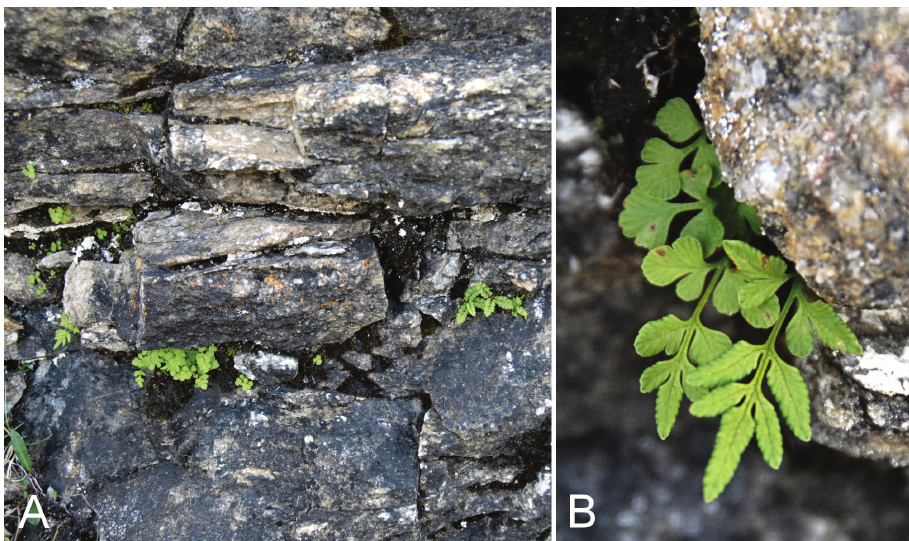
Figure 2. Cryptogramma stelleri : A habitat B habit, Saarela et al. 2774 . Photographs by L.J. Gillespie. 61°36'N). Our collection from 62°50'44"N on nearby Baffin Island represents a